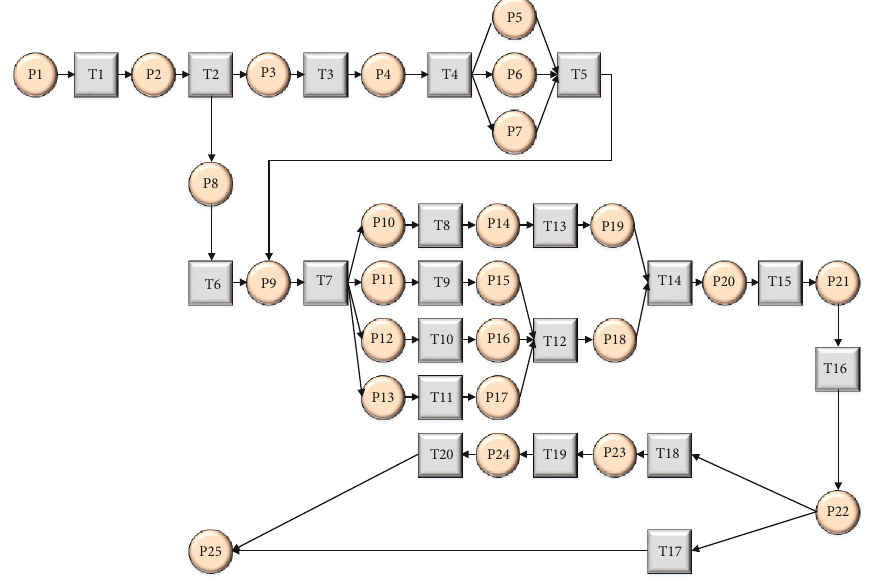
Figure 6: The SPN of ER process during coal mine accident.